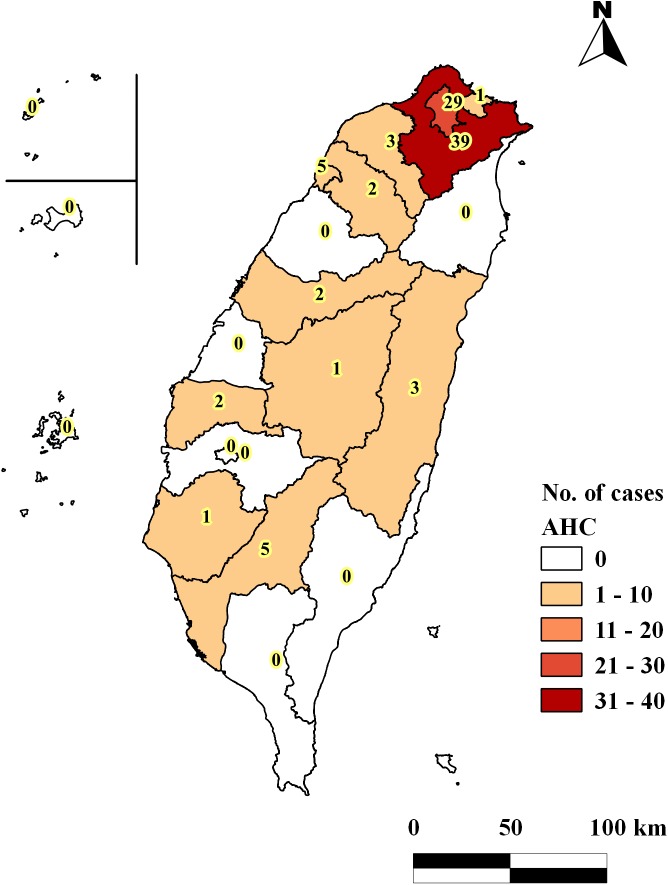
Number of HIV/AHC cases in each county and city, Taiwan, 2001–2014 aNumbers in the map indicate numbers of HIV/AHC cases in each city or county.This map is made by using the basemap provided by Taiwan Ministry of Interior under the Open Government Data License.